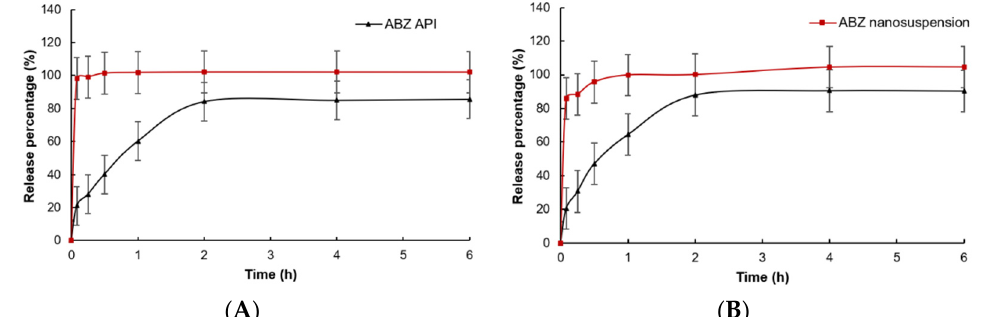
Figure 9. In vitro dissolution curves of native albendazole and albendazole. Nanocrystals in ( A ) pH = 2.0 PBS and ( B ) pH = 8.0 PBS (Mean ± SD, n = 6).